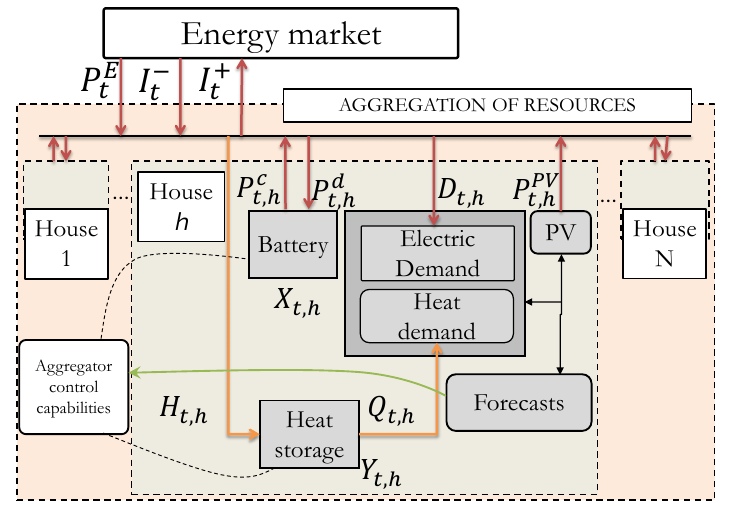
Figure 1. Schematic diagram of the proposed aggregation of